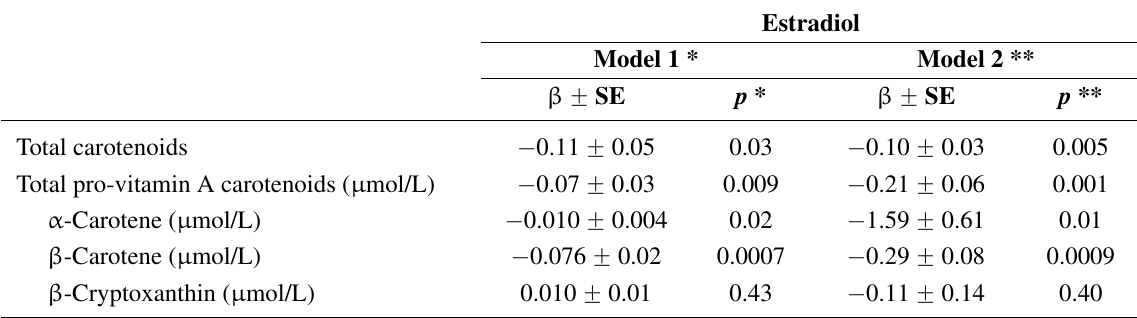
Table 2. Relationship between retinol, pro-vitamin A and non-provitamin A carotenoids and